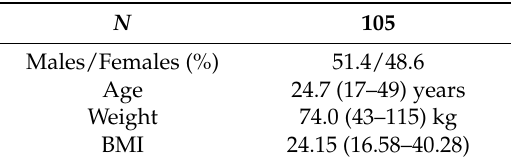
Table 1. Demographic and morphometric data of sample. Apart from gender figures are means with range in